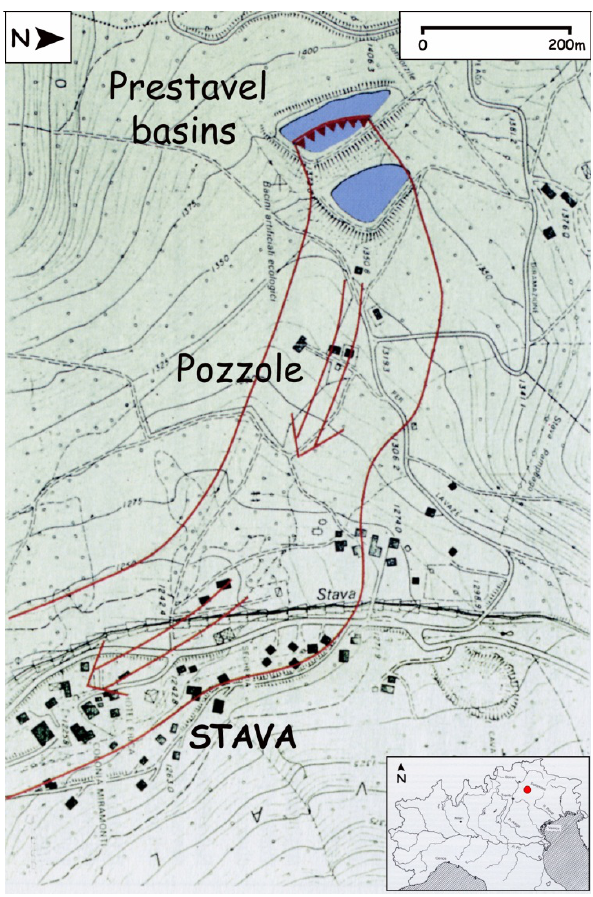
Fig. 1 – Stava village and the Prestavel basins in Fig. 1. Stava village and the Prestavel basins in the official map the official map before the collapse. Red lines before the collapse. Red lines show failure and the path of the mud- show failure and the path of the mudflow flow (courtesy of Fondazione Stava, (courtesy of Fondazione Stava 1985).